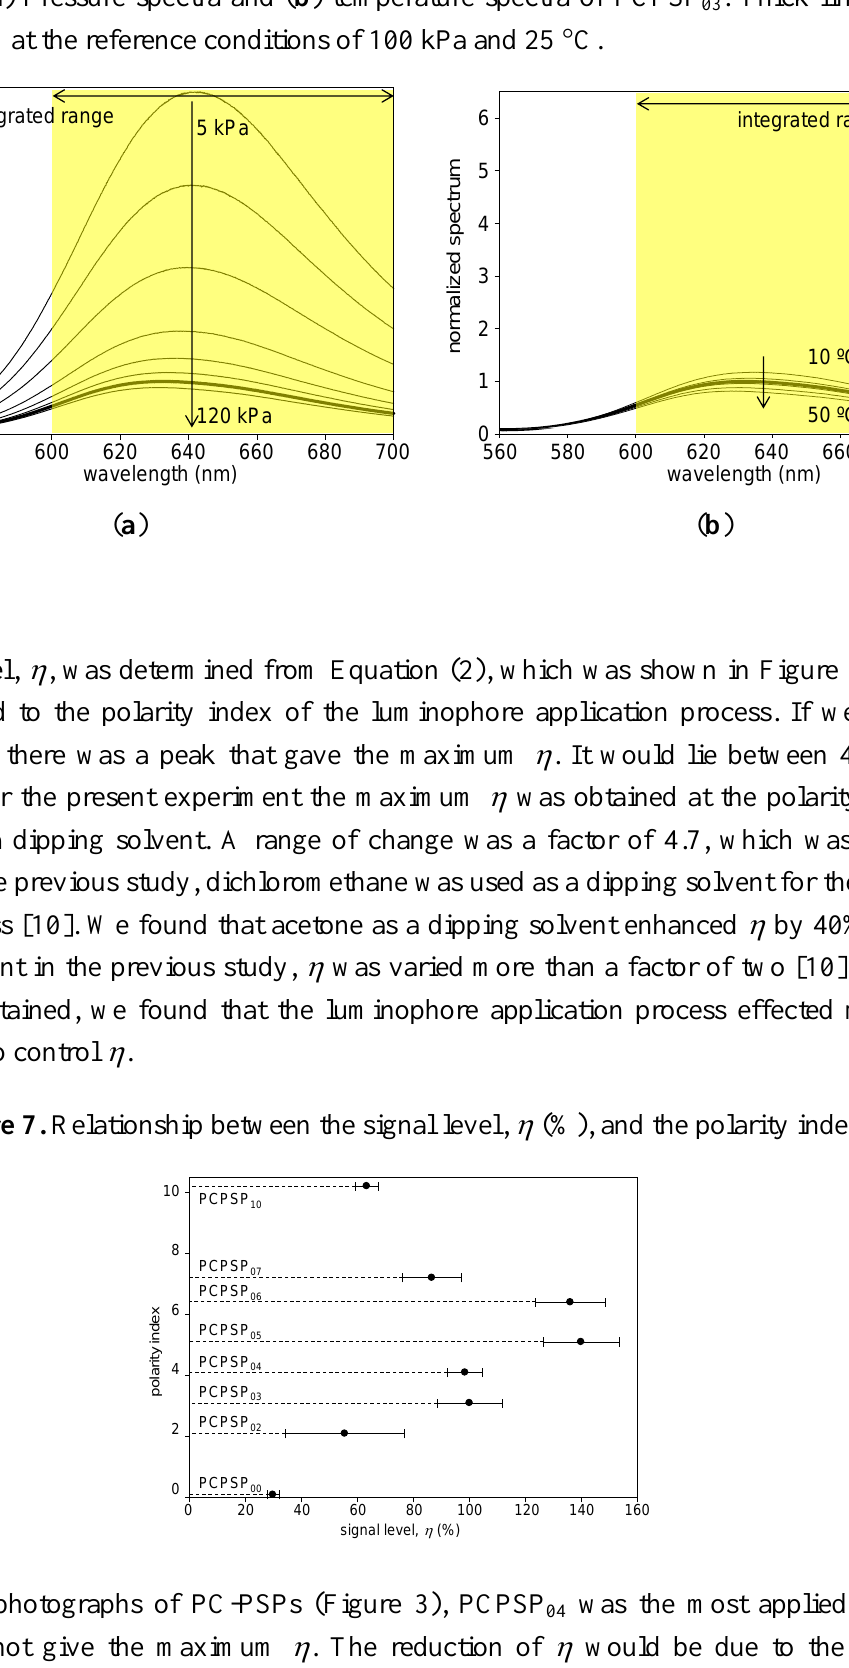
. Thick line shows 03